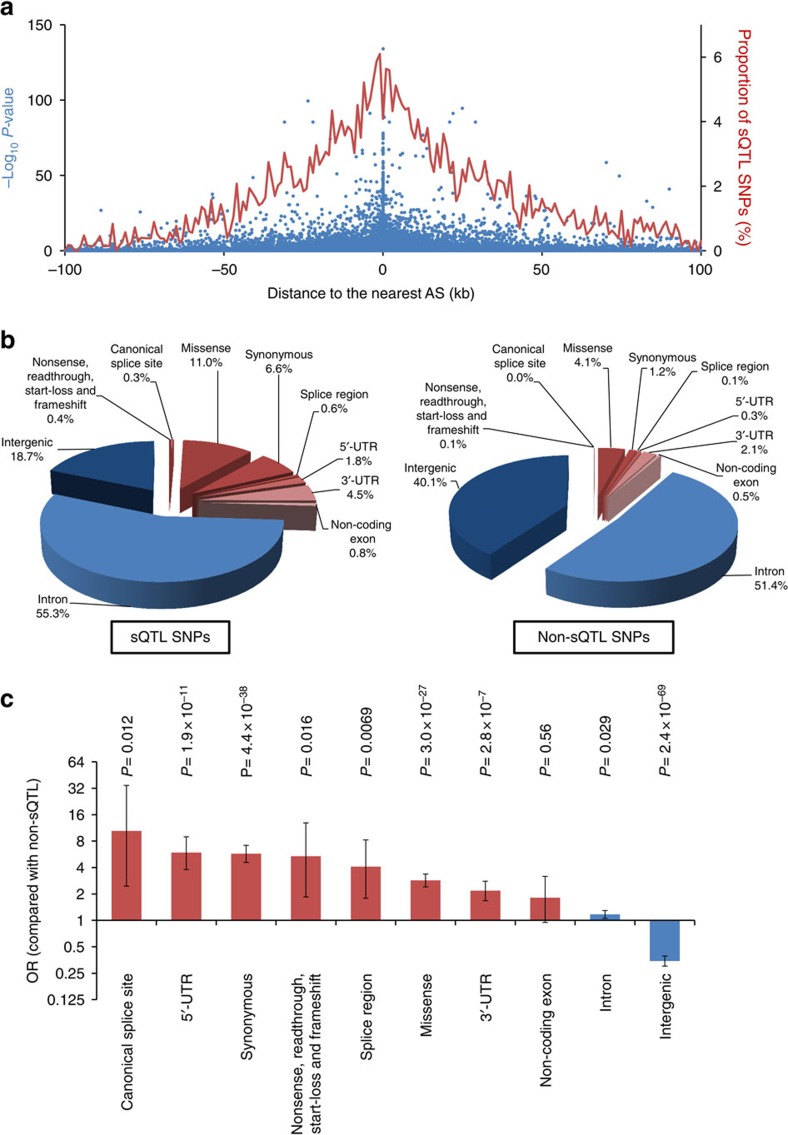
Characterization of identified sQTL SNPs.(a) Each blue dot indicates a SNP plotted according to its distance to the nearest AS event and statistical significance for association with AS (–log10
P-value). Red line indicates proportion of SNPs (%) that were classified as sQTL SNPs. Proportions in each 1,000 bp window were plotted. (b) Pie charts indicating proportions of SNPs annotated with each functional category (nonsense, readthrough, start-loss, frameshift, canonical splice site, missense, synonymous, splice region, 5′-UTR, 3′-UTR, non-coding exon, intron and intergenic). SNPs in exonic regions (nonsense, readthrough, start-loss, frameshift, canonical splice site, missense, synonymous, splice region, 5′-UTR, 3′-UTR and non-coding exon) and SNPs in non-exonic regions (intron and intergenic) are indicated by warm and cold colours, respectively. (c) Enrichment analyses of sQTL SNPs in each different functional type of variants. Exonic variants are shown in red and non-exonic variants are shown in blue. P-values were calculated by two-tailed Fisher's exact test with Bonferroni correction according to the number of functional types analysed (that is, ten types). Bars indicate 95% confidence intervals.